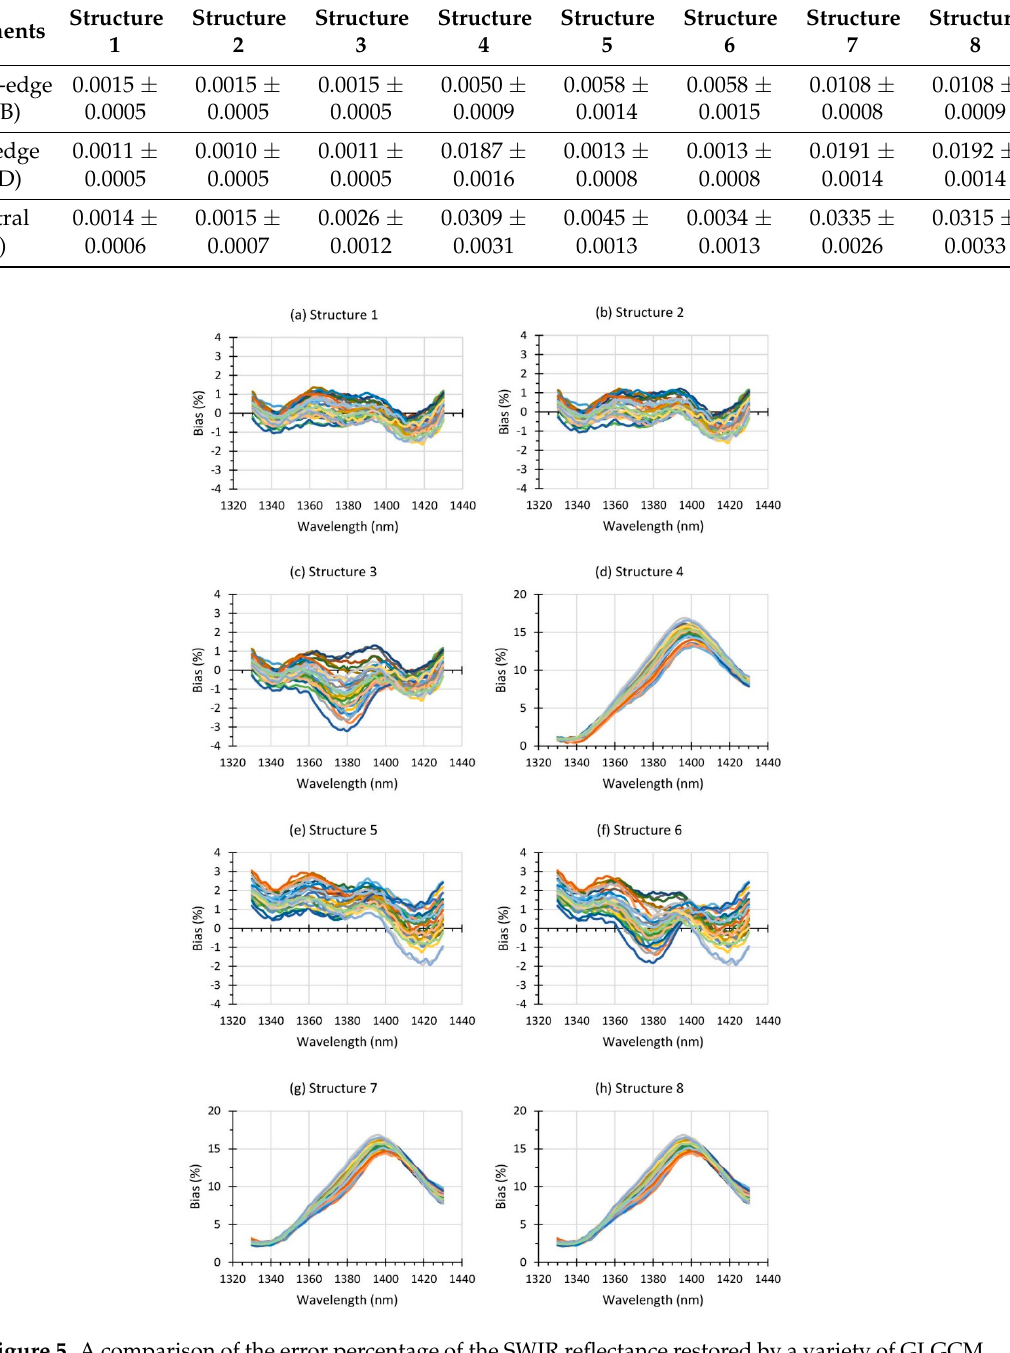
Figure 5. A comparison of the error percentage of the SWIR reflectance restored by a variety of GLGCM structures as described in Table 2.